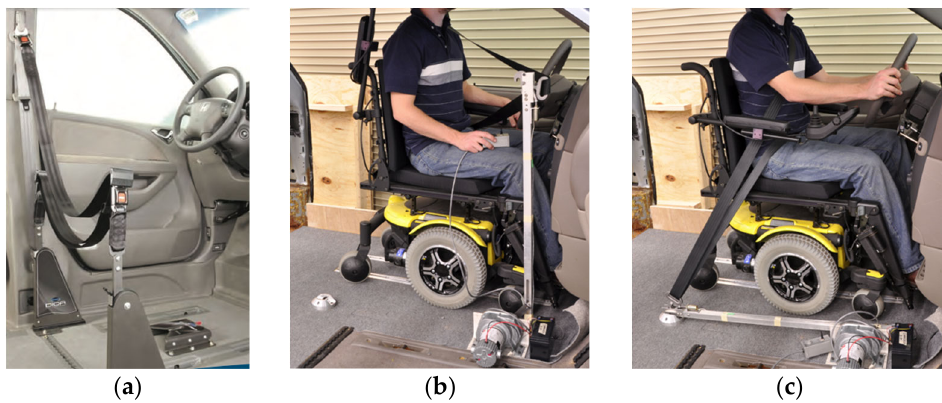
Figure 9. Q’Straint DIOR self ‐ donning belt system ( a ) and UMTRI prototype belt donning system ( b,c ).